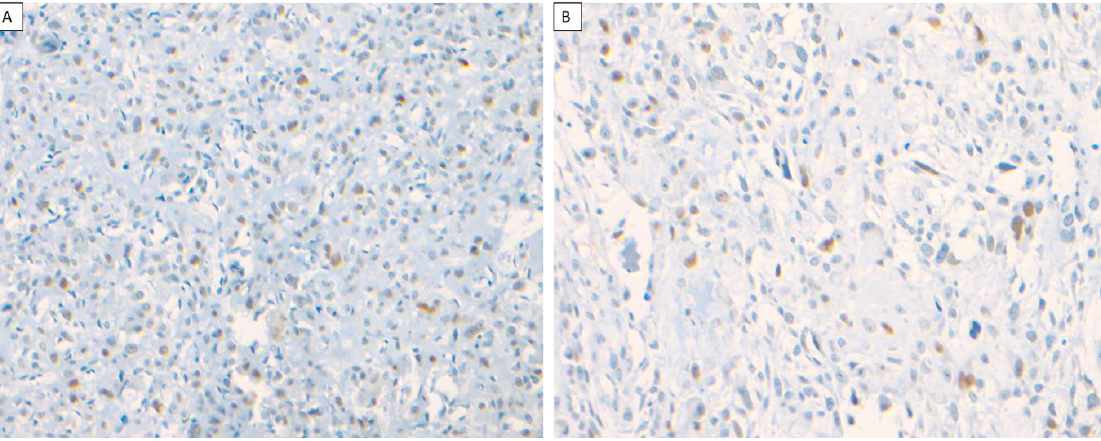
Figure 4. MDM2 expression in osteosarcoma. Osteosarcoma of the mandible in a 49-year-old male patient with nuclear expression of MDM2 in a diffuse staining pattern with moderate intensity (×200) ( A ), osteosarcoma of the mandible in a 19-year-old female patient with nuclear expression of MDM2 in a diffuse staining pattern with moderate intensity (×200) ( B ).